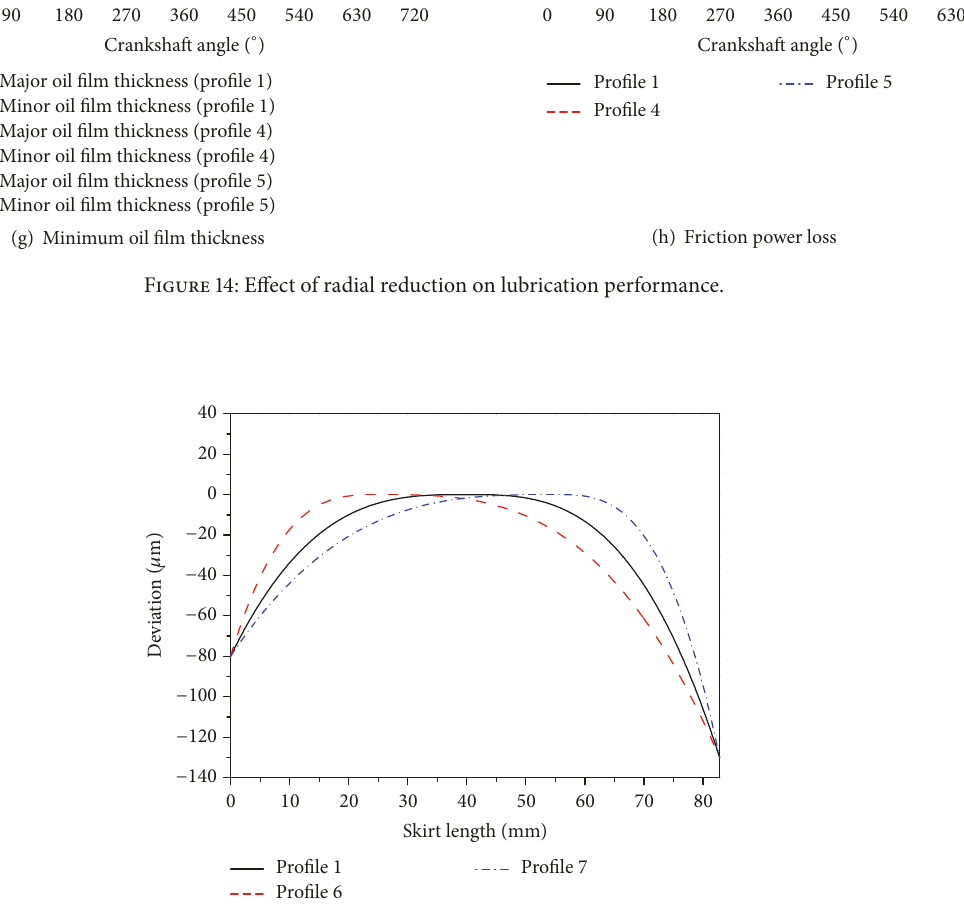
Figure 15: Profiles of different middle-convex point